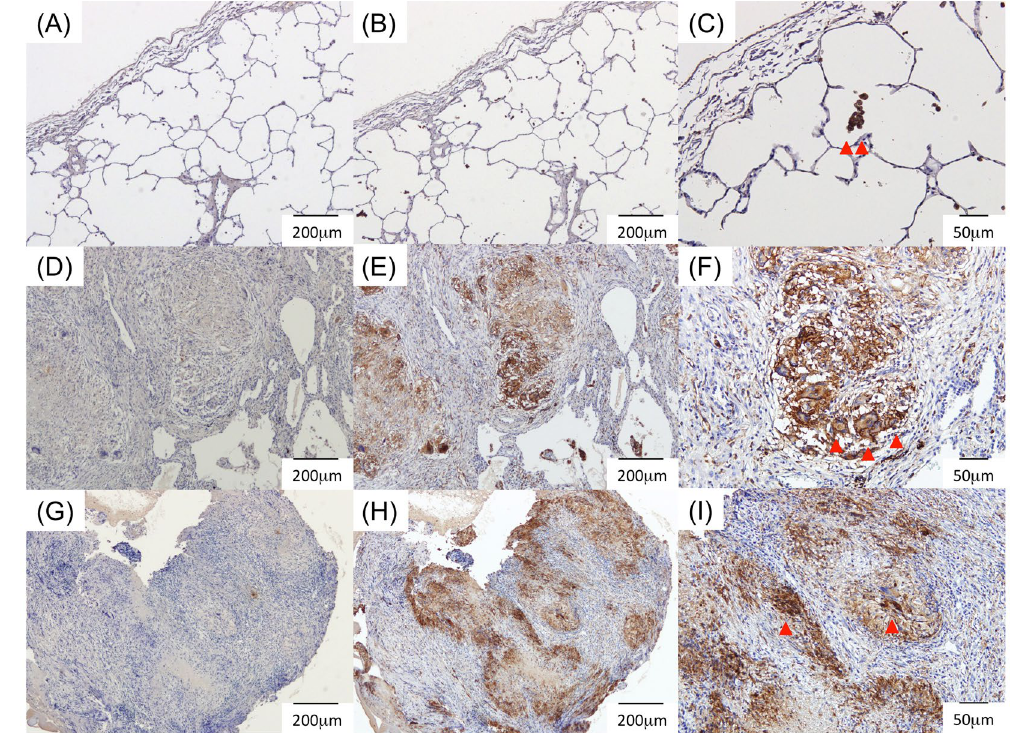
Figure 4. Immunohistochemical staining. Lung sections from an early lung cancer patient ( A – C ), patient with tuberculosis (TB, D – F ), and pleural tissues from patient with TB pleurisy ( G – I ). CD206 positive macrophages were observed (arrow head in C ). CD206 were stained with the caseating granulomas ( E , H ), and multinucleated giant cells (arrow head in F , I ). ( A , D , G ) Isotype controls (X40). ( B , E , H ) Anti-CD206 (X40). (C , F , I ) Anti-CD206